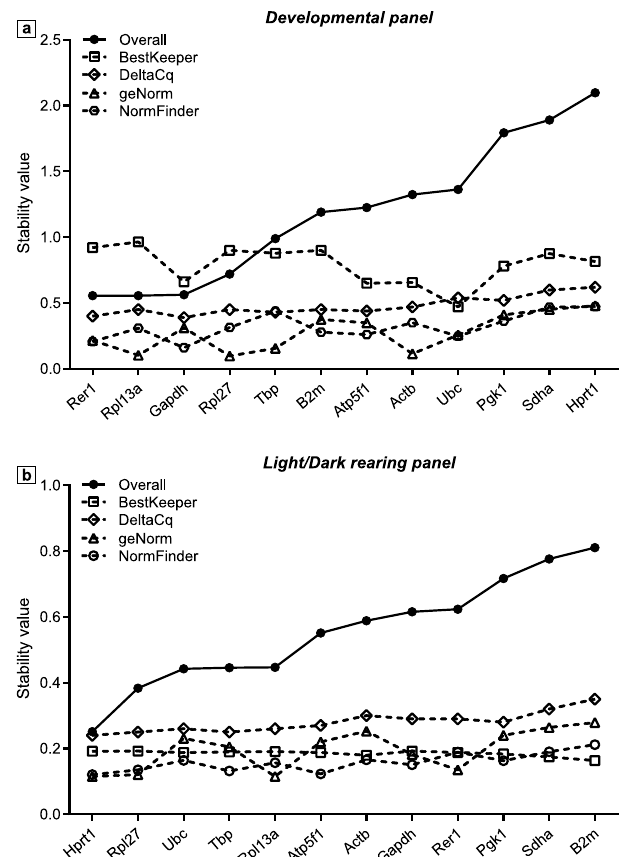
Figure 3. Conformity in rankings of reference genes by 4 methods. Stability ranking of 12 reference genes in the Developmental ( a ) and in the Light/Dark rearing ( b ) panels, calculated per assessment method (geNorm, triangle; NormFinder, hexagon; BestKeeper, square; DeltaCq, diamond) and as geometric mean of the 4 rankings (Overall, full black circle) (see Table 3 for more